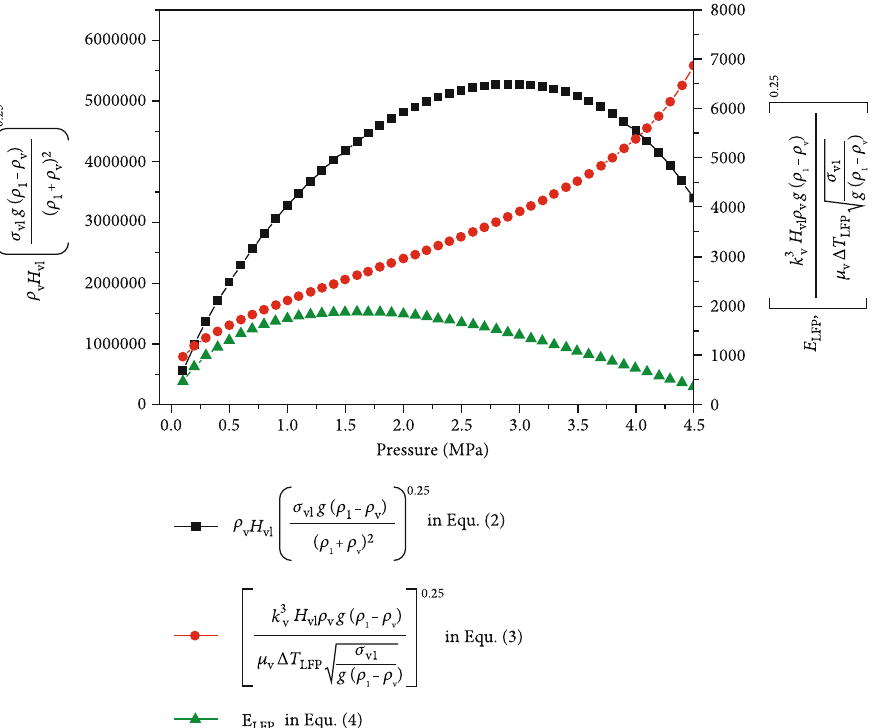
Figure 16: Parameter combinations in Equations (2) – (4) versus pressure.